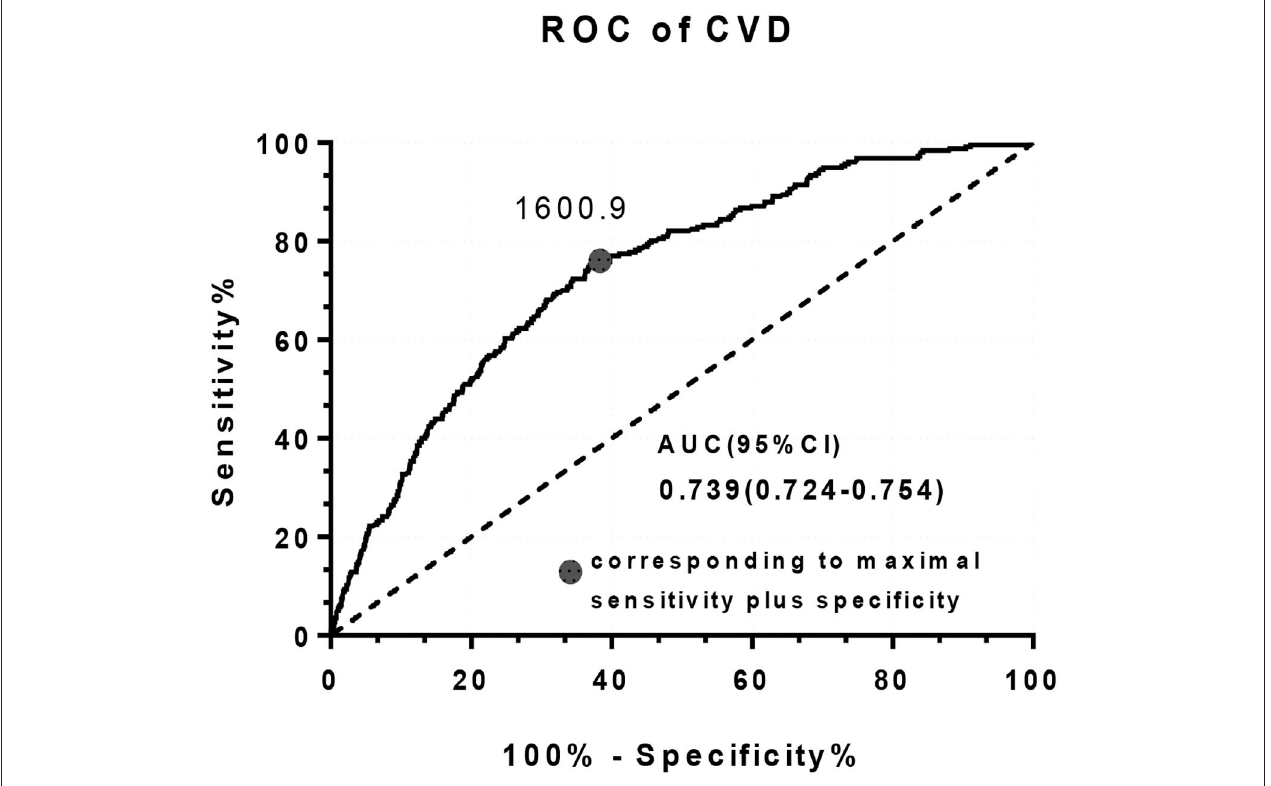
FIGURE 2 | The receiver operating characteristics (ROC) curve for brachial-ankle pulse wave velocity (baPWV) to detect CVD.